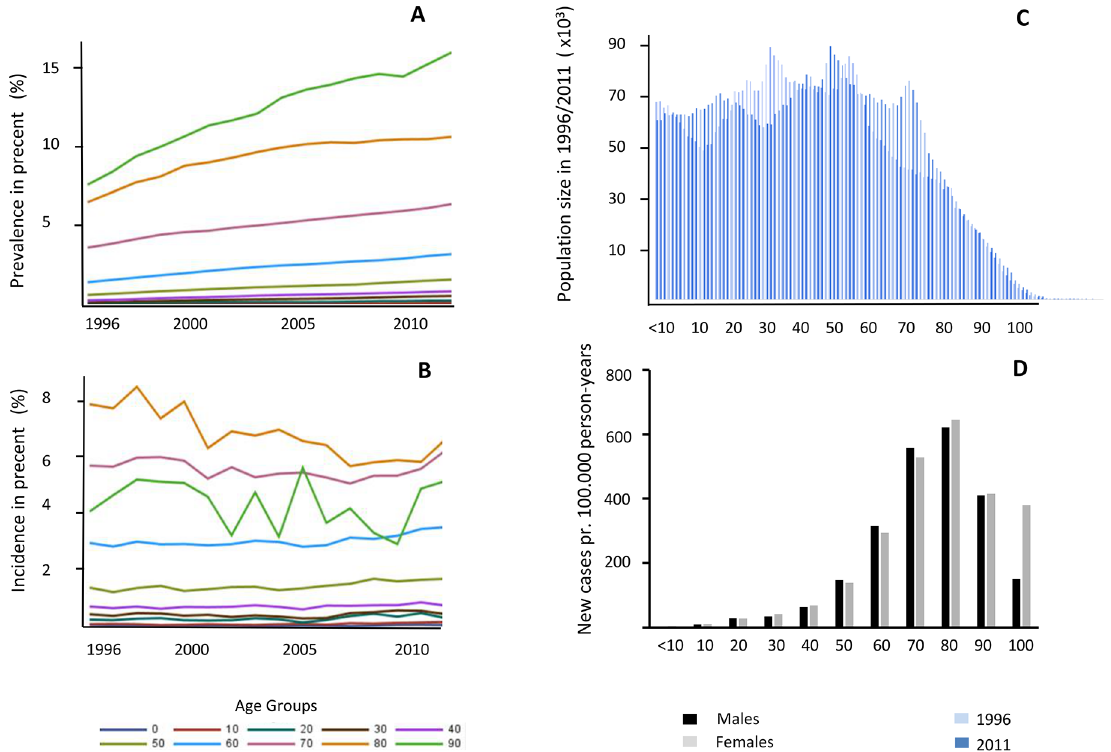
Fig 1. Prevalence, Incidence and age distribution of glaucoma patients in Denmark. A. Prevalence of glaucoma cases in Denmark in the period from 1996 to 2011. The percentage of female glaucoma patients above 50 years is shown in age intervals of 10 years. A significant increase in the prevalence throughout the period was found ( p < 0.001). No significant difference is seen among females and males ( p = 0.8). B. Incidence of glaucoma cases in Denmark in the period from 1996 to 2011. The percentage of female glaucoma patients above 50 years is shown in age intervals of 10 years. No significant difference is seen among females and males ( p = 0.1). No significant change was observed in the incidence in the studied period. C. The age distribution in Denmark from 1996 and 2011. In 1996 the total population was 5.3 million and in 2011 5.6 million, respectively. Numbers are drawn from the Danish National Patient Registry. D. The age specific incidence rates of glaucoma in Denmark in the period from 1996 to 2011. Out of a total of 116,594 cases, the incident rates reveal a bell shaped distribution with a peak at the age of 80 years by 600 cases per 100,000 person-years.